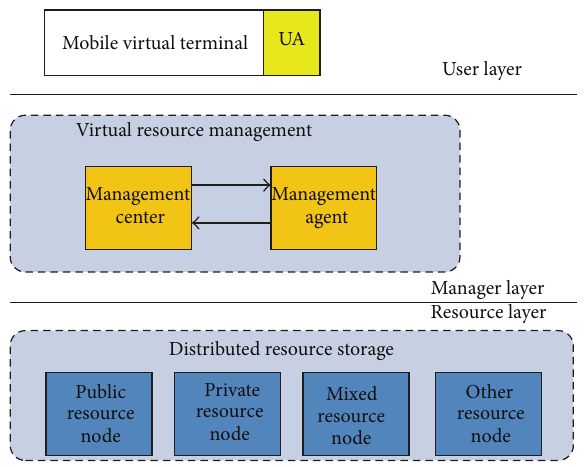
Figure 3: Architecture of SRSM.